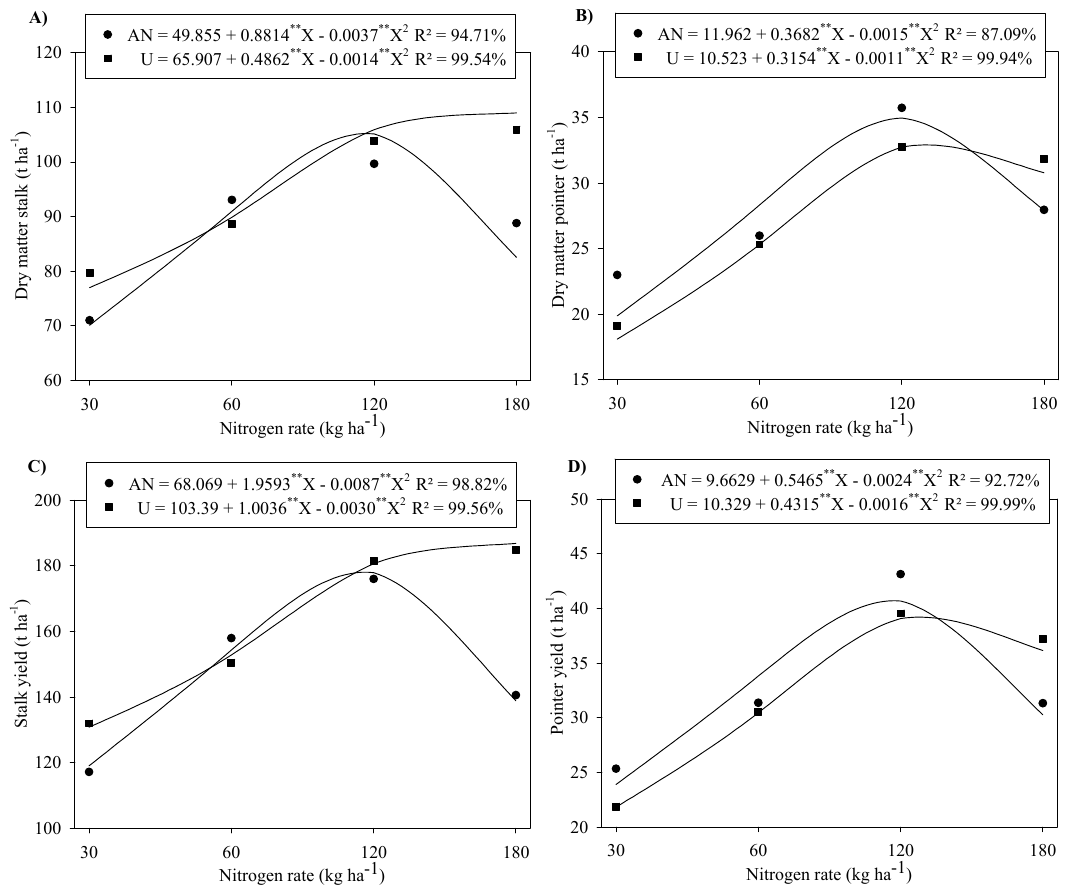
Figure 4. Dry matter stalk ( A ) and dry matter pointer of sugarcane ( B ), stalk yield ( C ), and pointer yield of sugarcane ( D ), in the cane plant cycle, as affected by N rate as ammonium nitrate (AN) and urea (U). ** Significant respectively at 1% probability according to test F.